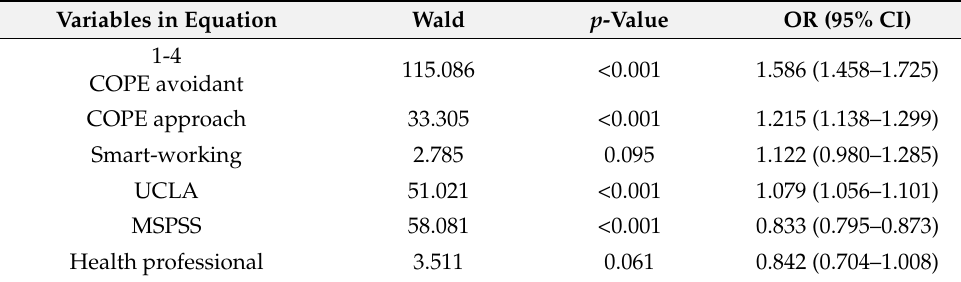
Table 3. Logistic regression analyzing factors associated with access to mental health care resources in the study population. The model was corrected for gender, age, and time when the interview was